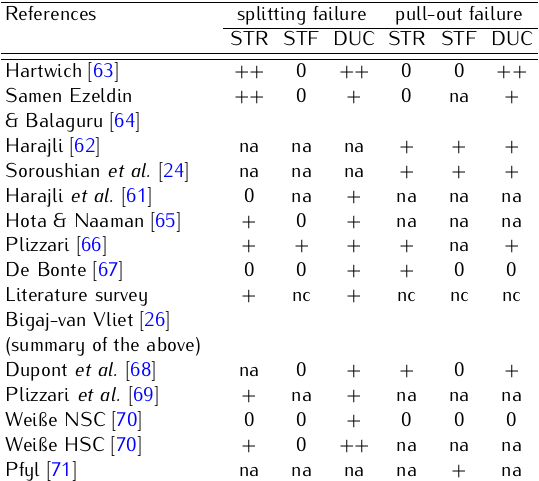
Table 9. Summary of the influence of the addition of hooked-end steel fibers on the bond